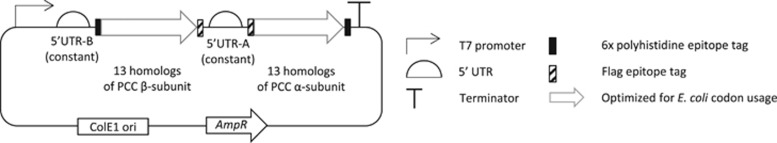
Scheme of genetic constructs of 13 engineered propionyl-CoA carboxylase complexes. 5′UTR, 5′ untranslated region; AmpR, ampicillin resistance gene; ColE1 ori, colicin E1 origin of replication; PCC, propionyl-CoA carboxylase.